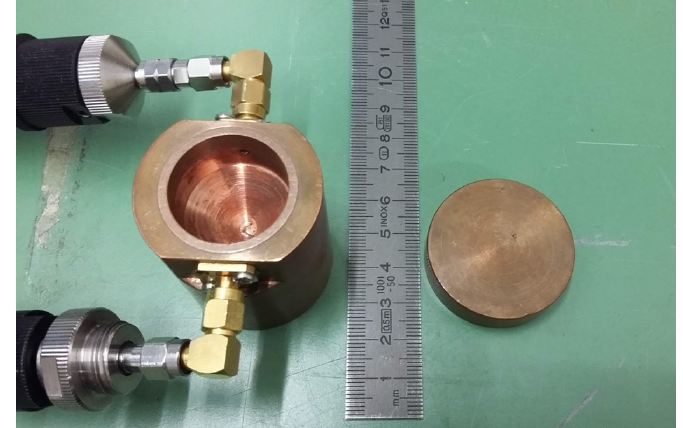
Figure 20. Fabricated cylindrical resonator with removable end